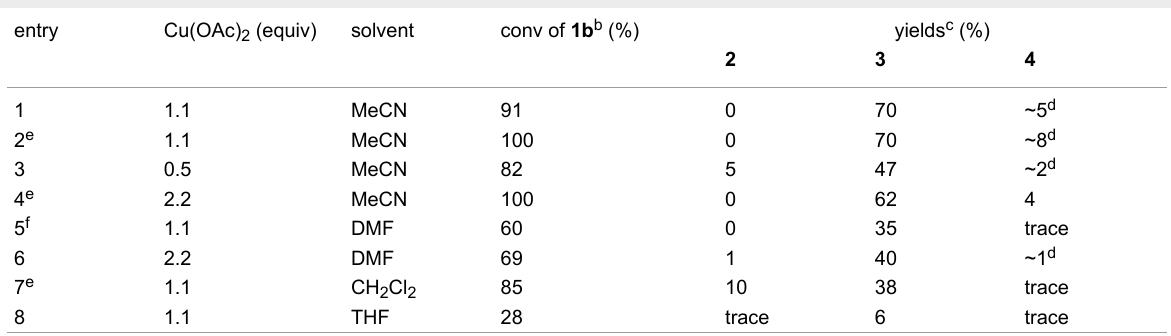
Table 1: Reaction of cyclopropanol 1b with Cu(OAc) 2 . a